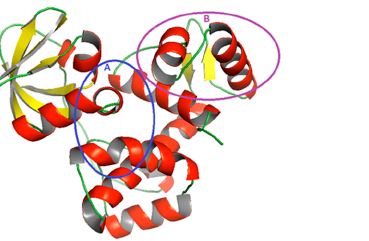
Figure 1. A cartoon representation of the 3D homology model of IdeR of M. ulcerans . Alpha helixes are colored in red, beta sheets in yellow and loops in green. Region ‘A’ circled in blue indicates the area of the metal binding pockets whilst region ‘B’, circled in violet shows the DNA–binding domain of the protein.